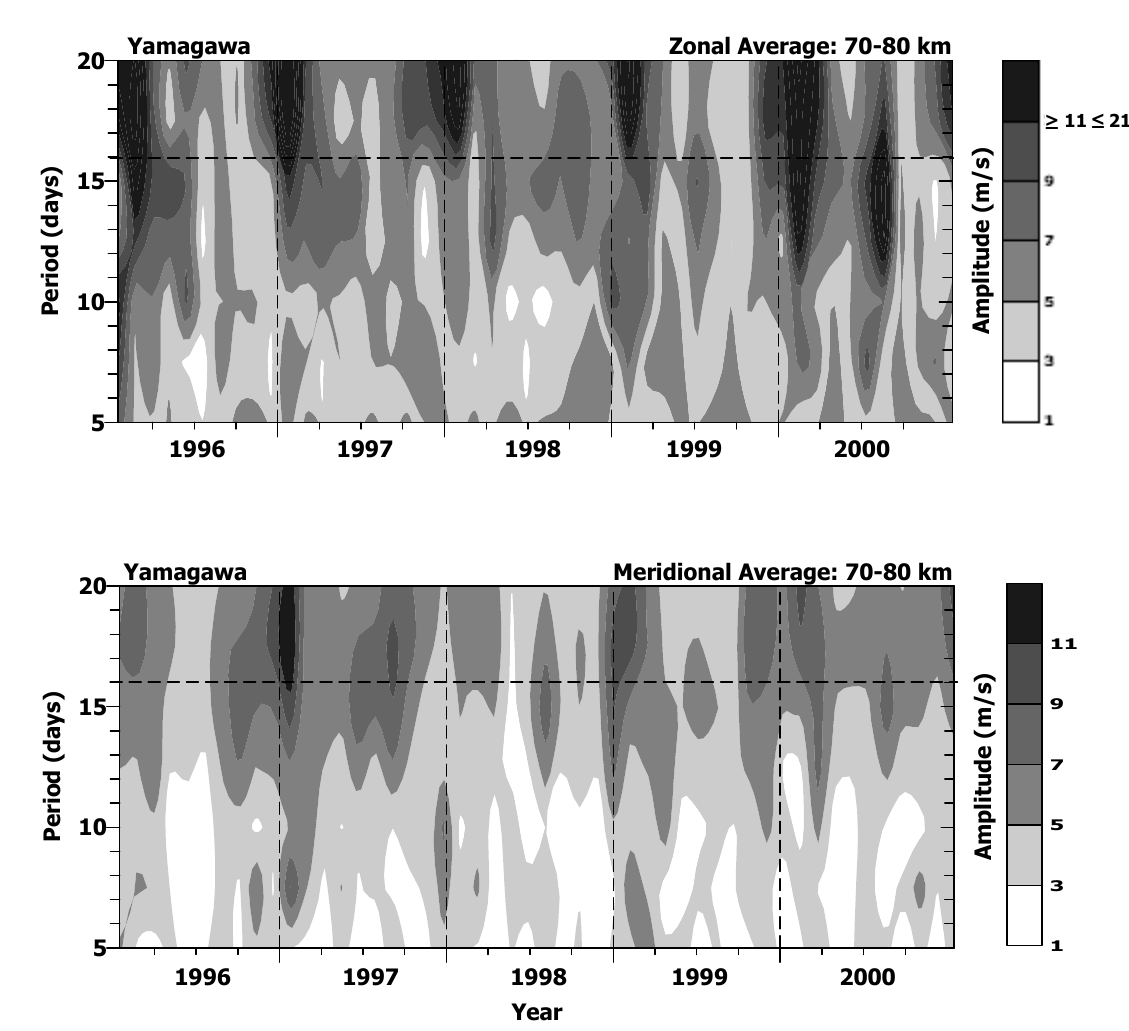
Fig. 3. Averaged (70–80km) Lomb-Scargle periodograms (5–20 days) of the Yamagawa zonal and meridional daily mean winds during the period